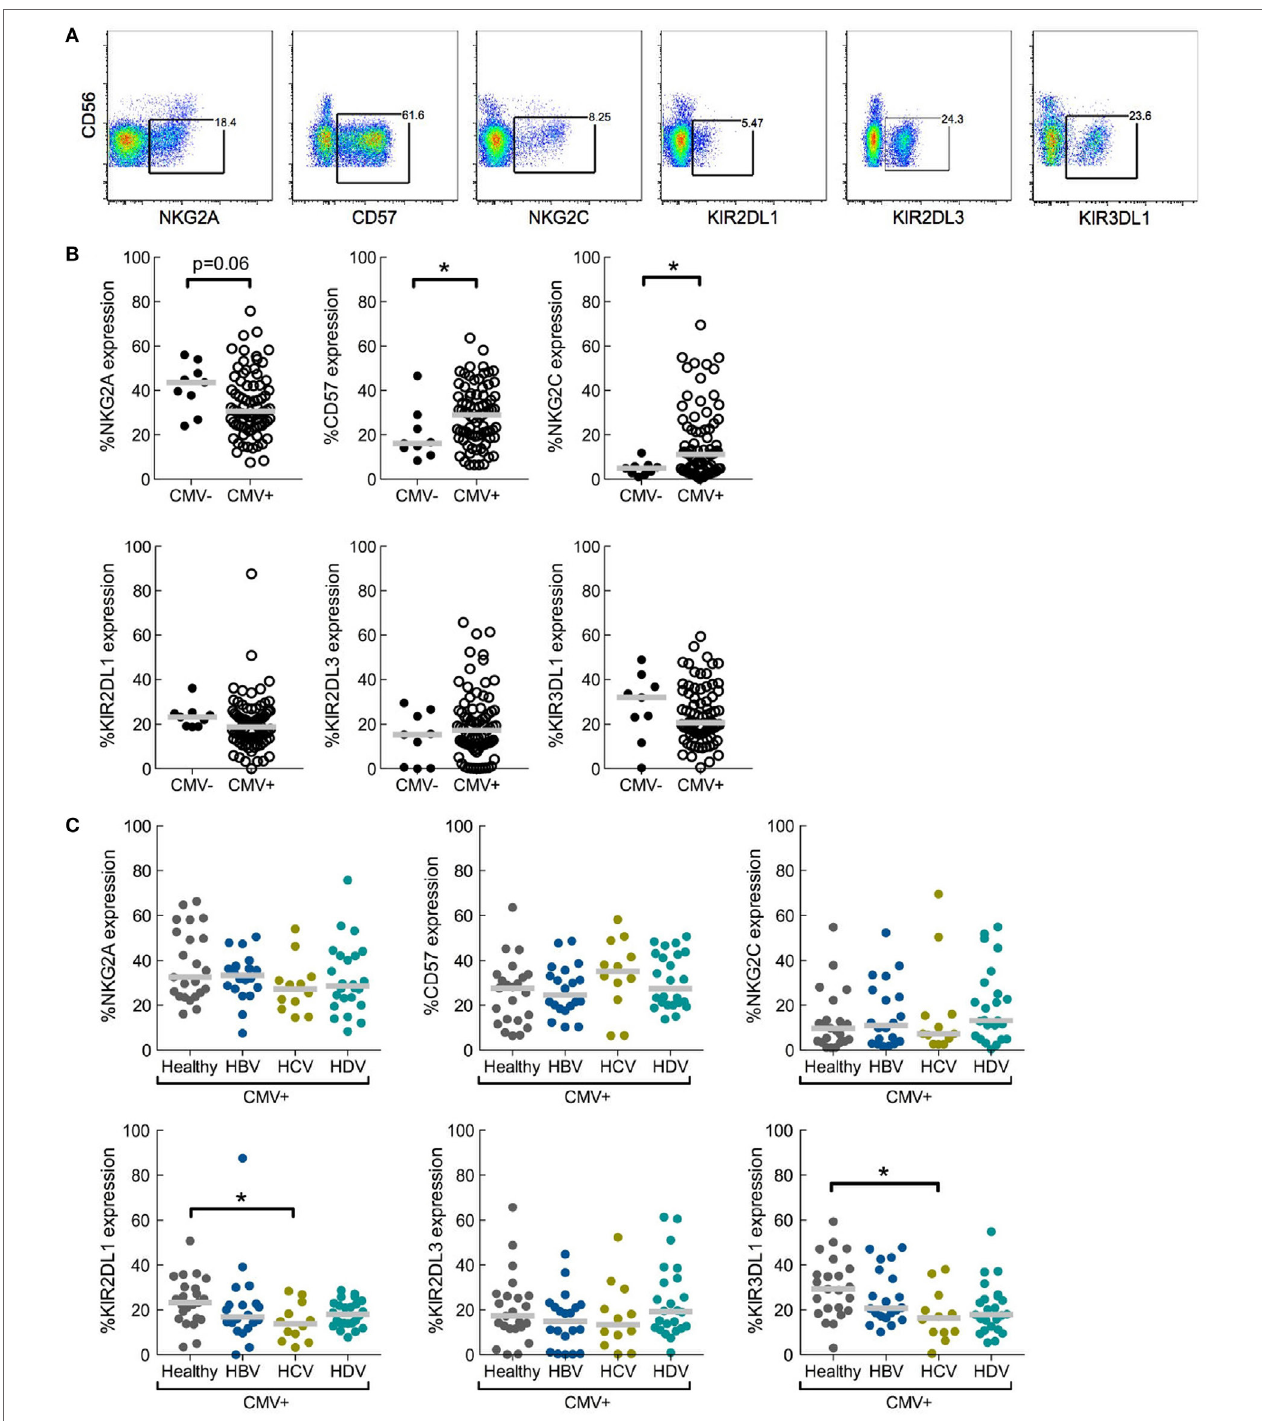
FigUre 1 | role of underlying cytomegalovirus (cMV) infection in chronic viral hepatitis infections with respect to effects of natural killer (nK) cell differentiation and killer-cell immunoglobulin-like receptor (Kir) expression . (a) Representative staining of differentiation-associated receptors on CD56 dim NK cells. Data shown from total lymphocytes have CD3, CD4, CD14, CD19, and dead cell marker positive cells excluded. (B) Expression of NKG2A, CD57, NKG2C, KIR2DL1, KIR2DL3, and KIR3DL1 on CD56 dim NK cells in CMV seronegative (CMV − ) or seropositive (CMV + ) individuals, irrespective of hepatitis status; CMV − n = 9 and CMV + n = 79. Statistical analysis performed with Mann–Whitney test. (c) Expression of NKG2A, CD57, NKG2C, KIR2DL1, KIR2DL3, and KIR3DL1 on CD56 dim NK cells in CMV seropositive individuals split into healthy ( n = 23) and hepatitis virus infected [ n = 20, 12, and 24 for hepatitis B virus (HBV), hepatitis C virus (HCV), and hepatitis delta virus (HDV), respectively]. Statistical analysis performed with Kruskal–Wallis test and Dunn’s multiple comparison. Gray bar indicates median. * p < 0.05.